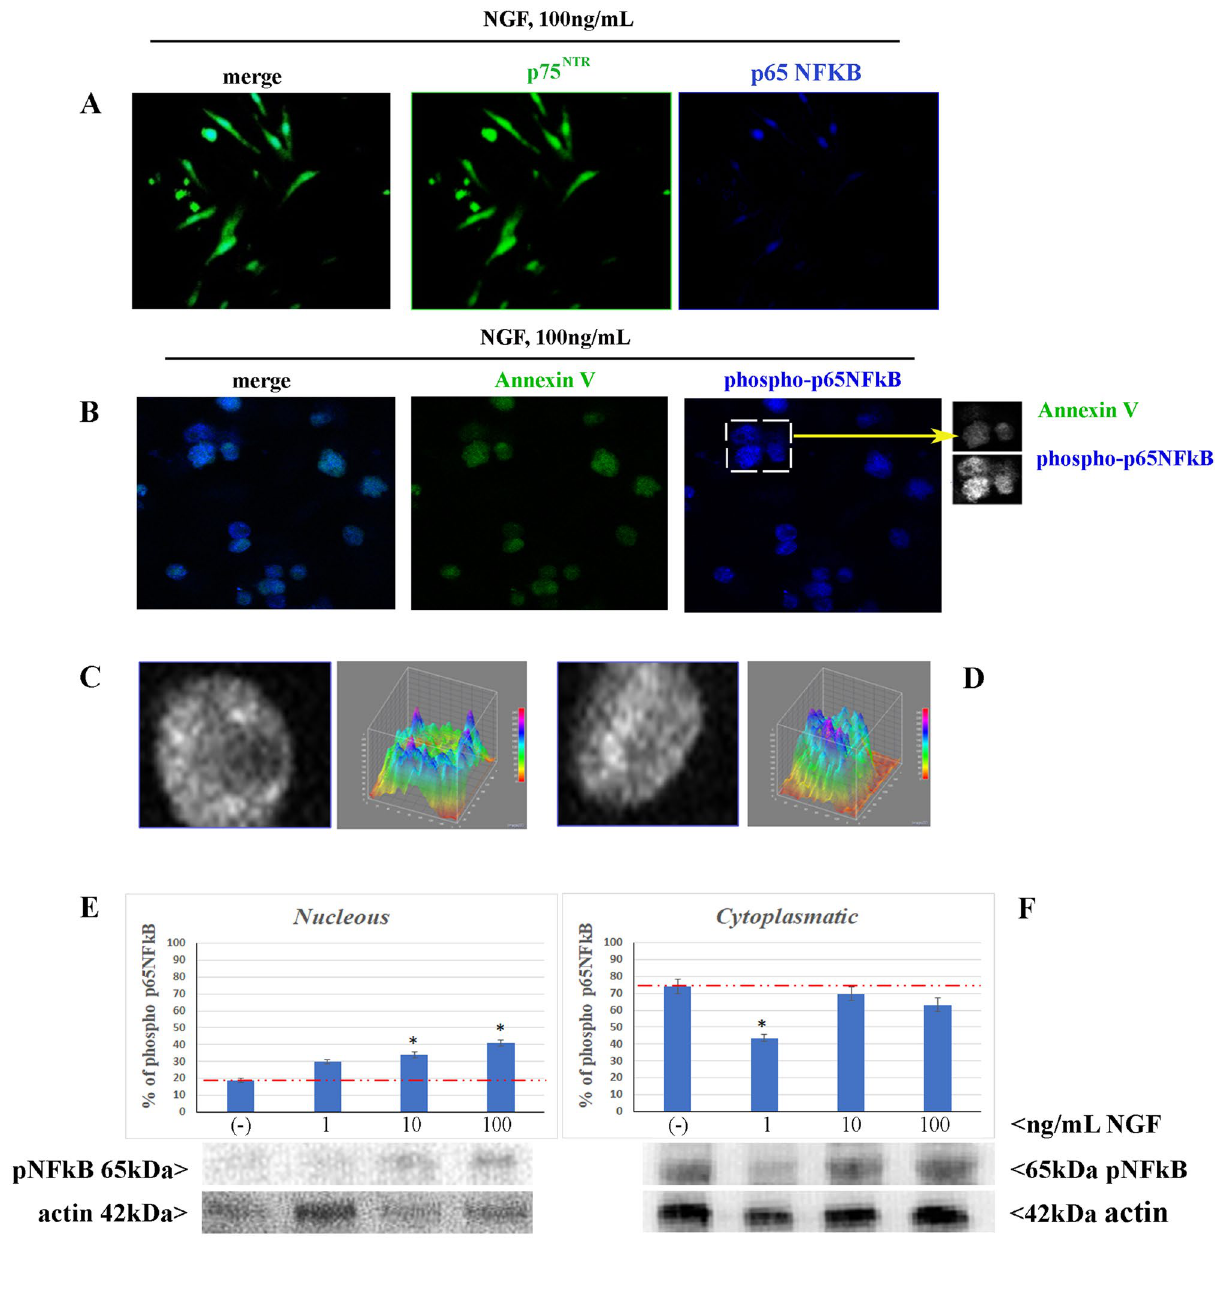
Figure 2. NGF triggers p65-NFkB phosphorylation and nuclear translocation. Cells were exposed to repeated (chronic) 100 ng/mL stimulation and sampled at 24 h for phosphorylation and translocation analysis of